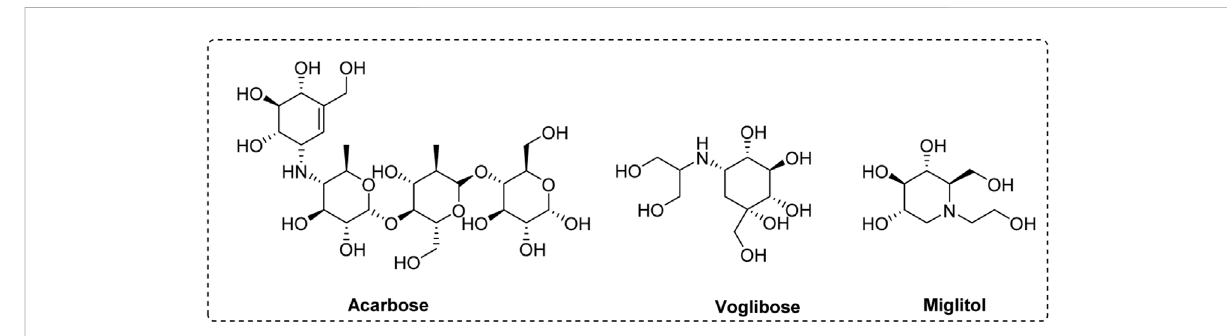
FIGURE 1 The chemical structure of acarbose, voglibose, and miglitol.